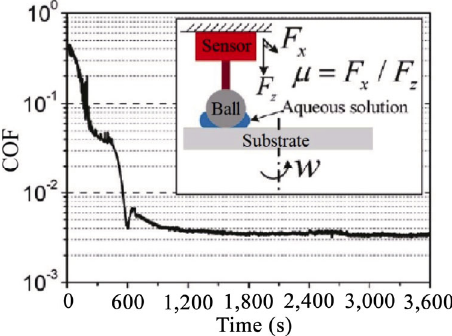
Fig. 2 COF of H 3 PO 4 aqueous solution (pH 1.5). F x is friction force, F z is applied load, and μ is COF. Reproduced with permission from Ref. [30], © American Chemical Society